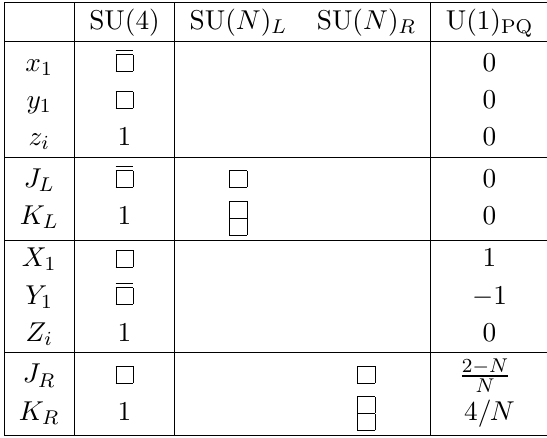
(cid:2) SU( N ) R U(1) PQ (cid:2) (cid:2)